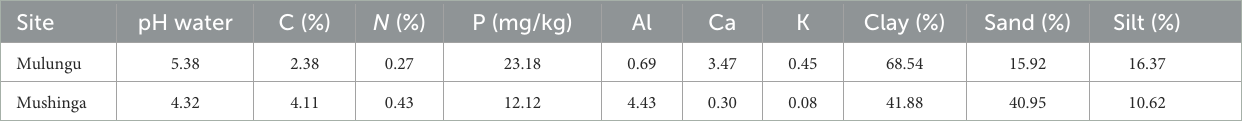
TABLE 1 Soil characteristics from soil samples collected in 2016 at the Mulungu and Mushinga experimental field sites.